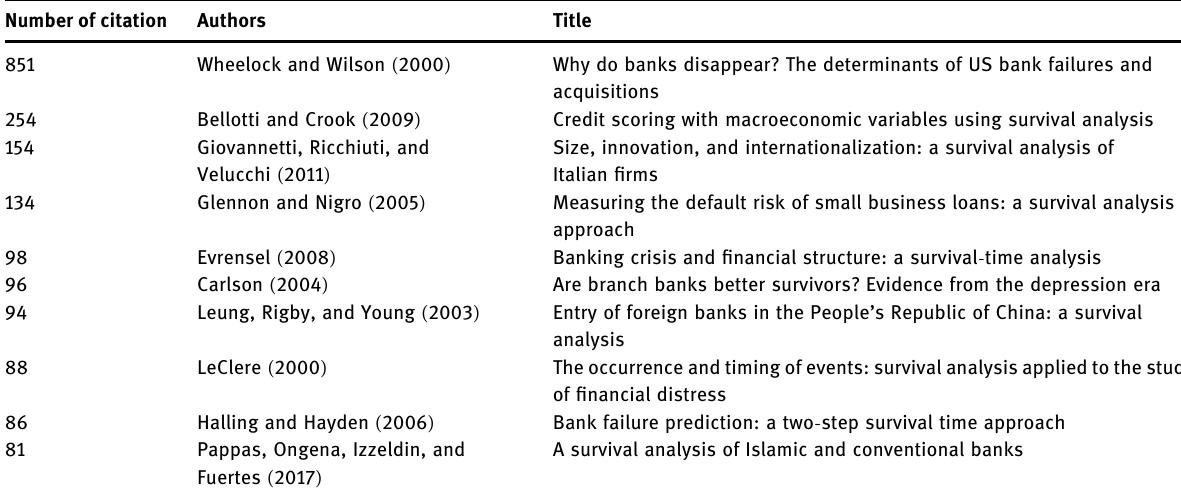
Table 3: Represents top - 12 papers based on citation Number of